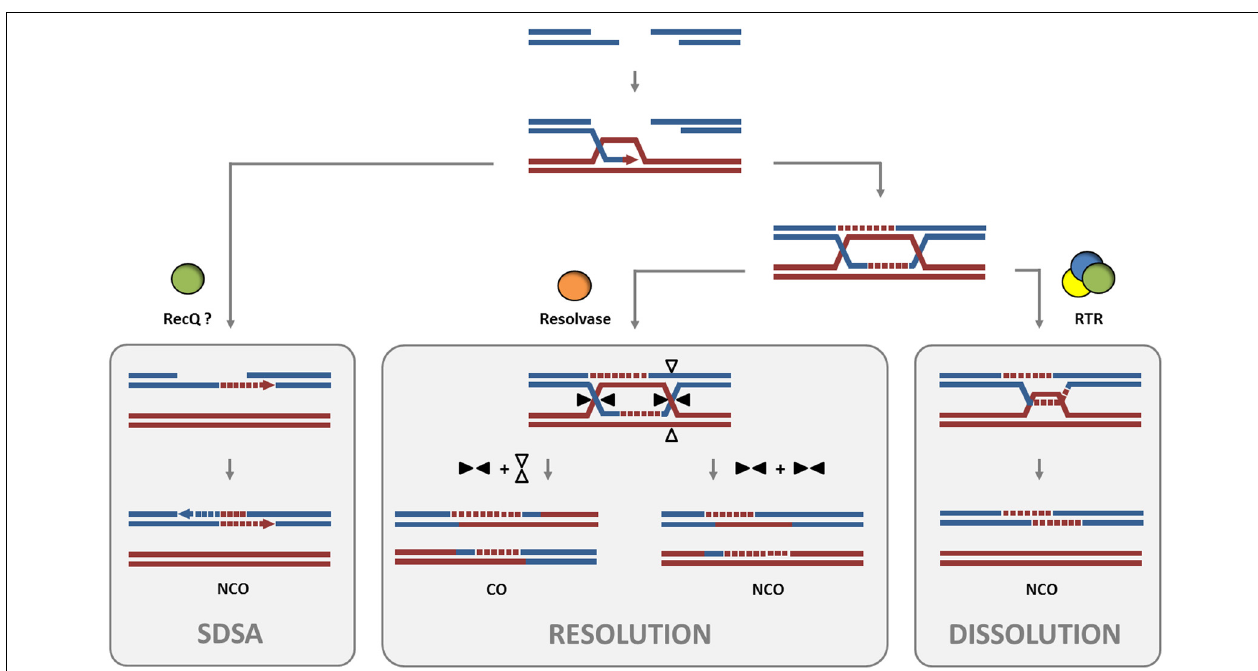
RTR complex, a RecQ family DNA helicase branch migrates the two junctions to form a hemicatenane structure. This hemicatenane is processed by the type IA topoisomerase into a NCO product. The non-catalytic protein RMI1 interacts with the RecQ helicase and topoisomerase and promotes the dissolution reaction. Alternatively, the dHJ structure can be processed by a structure-specific endonuclease, also called a HJ resolvase, in the resolution pathway. Here, depending on the orientation of the cut axis (arrowheads), either CO or NCO products are possible. Other orientations of the cuts by the resolvase would lead to similar CO or NCO outcomes and are not